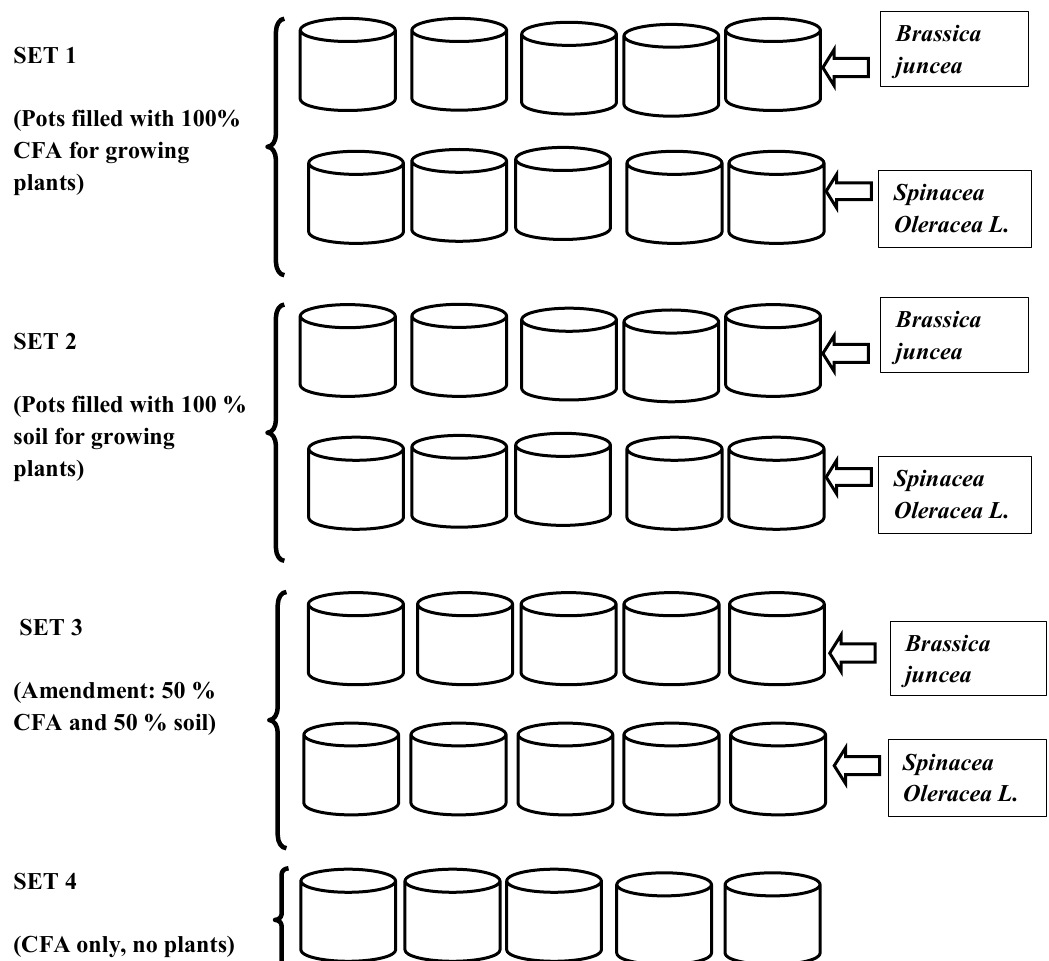
Figure 1. Illustration of pot setup (materials used in each pot and ratio used in case of combination is indicated; species grown in each pot is also shown). CFA: Coal-fly-ash.